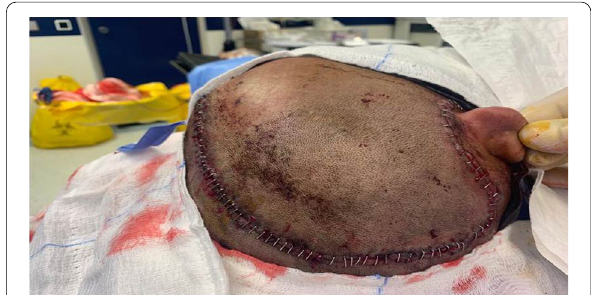
Fig. 1 RQM incision: starting 1–2 cm anterior to the tragus at the root of the zygoma, the large reverse question mark scalp incision curves posteriorly above and gently behind the ear toward the asterion. After that, the incision softly curves around the parietal eminence to the midline and then onward to the hairline